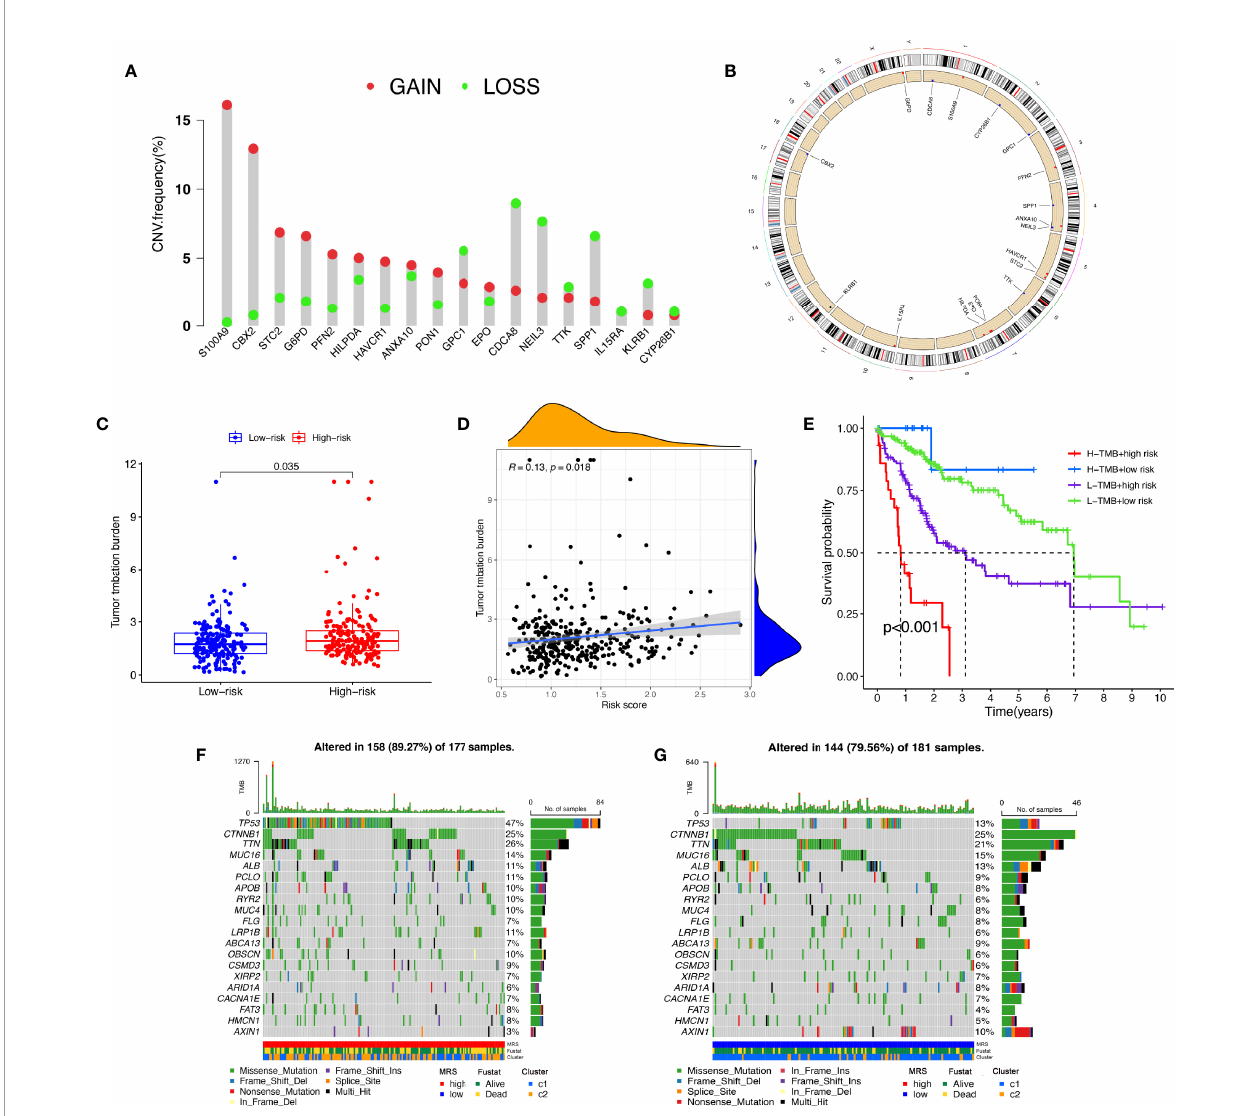
FIGURE 10 | Tumor mutation analysis between different MRS signature groups. (A) Circus plots of chromosome distributions of selected genes from the MRS signature. (B) Frequencies of gain and loss for selected genes from the MRS signature. (C) Box plot showing tumor mutation burden in the high- and low-risk groups. (D) Risk scores from the MRS signature are correlated with TMB score in the TCGA dataset. (E) The Kaplan – Meier curve survival analysis for HCC patients strati fi ed by both TMB groups and MRS signature. Waterfall plot displaying gene mutations in the high- (F) and low-risk (G)